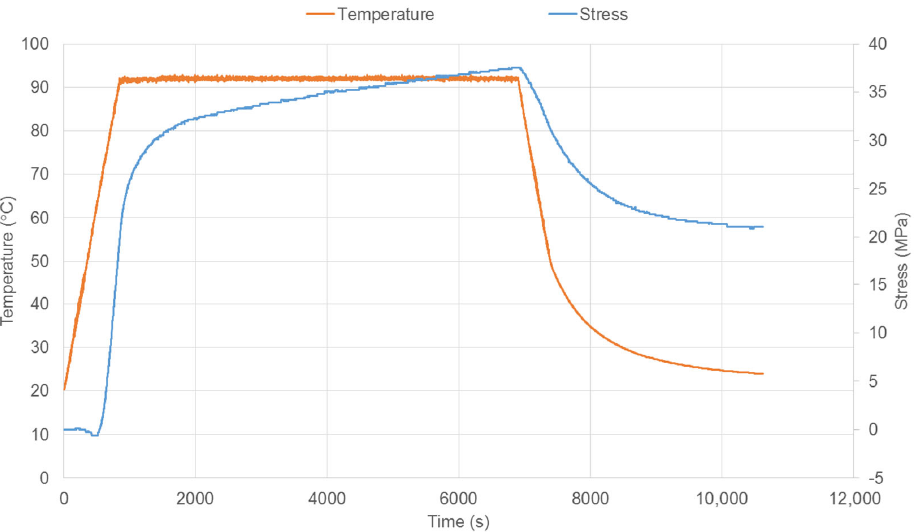
Figure 3. Evolution of shrinkage restraint stress for a single PET fibre.